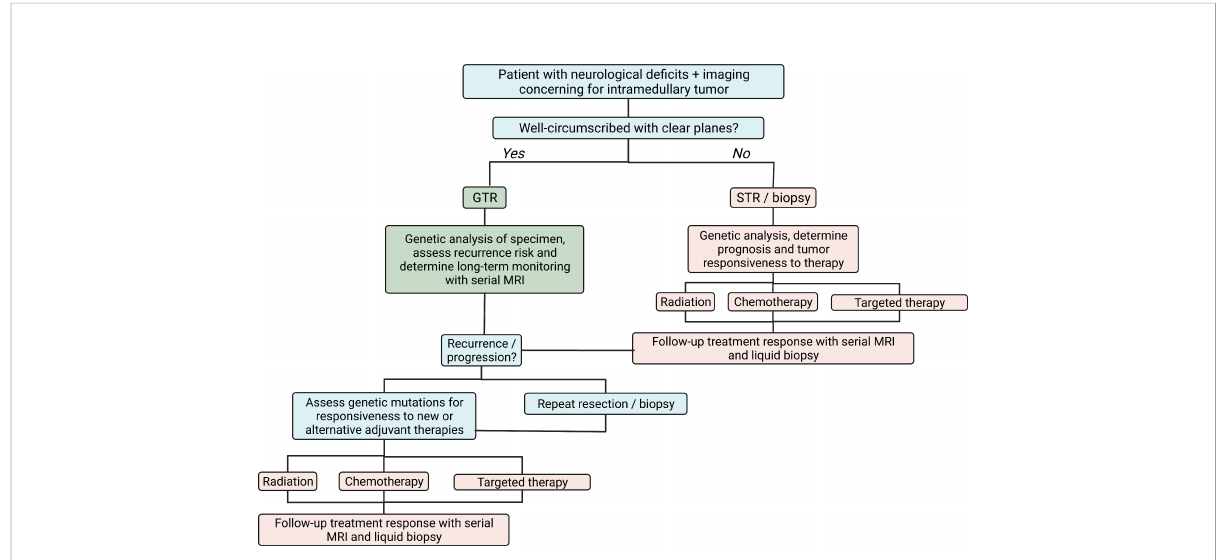
FIGURE 3 Algorithm to guide surgical decision-making and adjuvant treatment in patients with intramedullary astrocytomas using genetic analysis of tumors. Created with